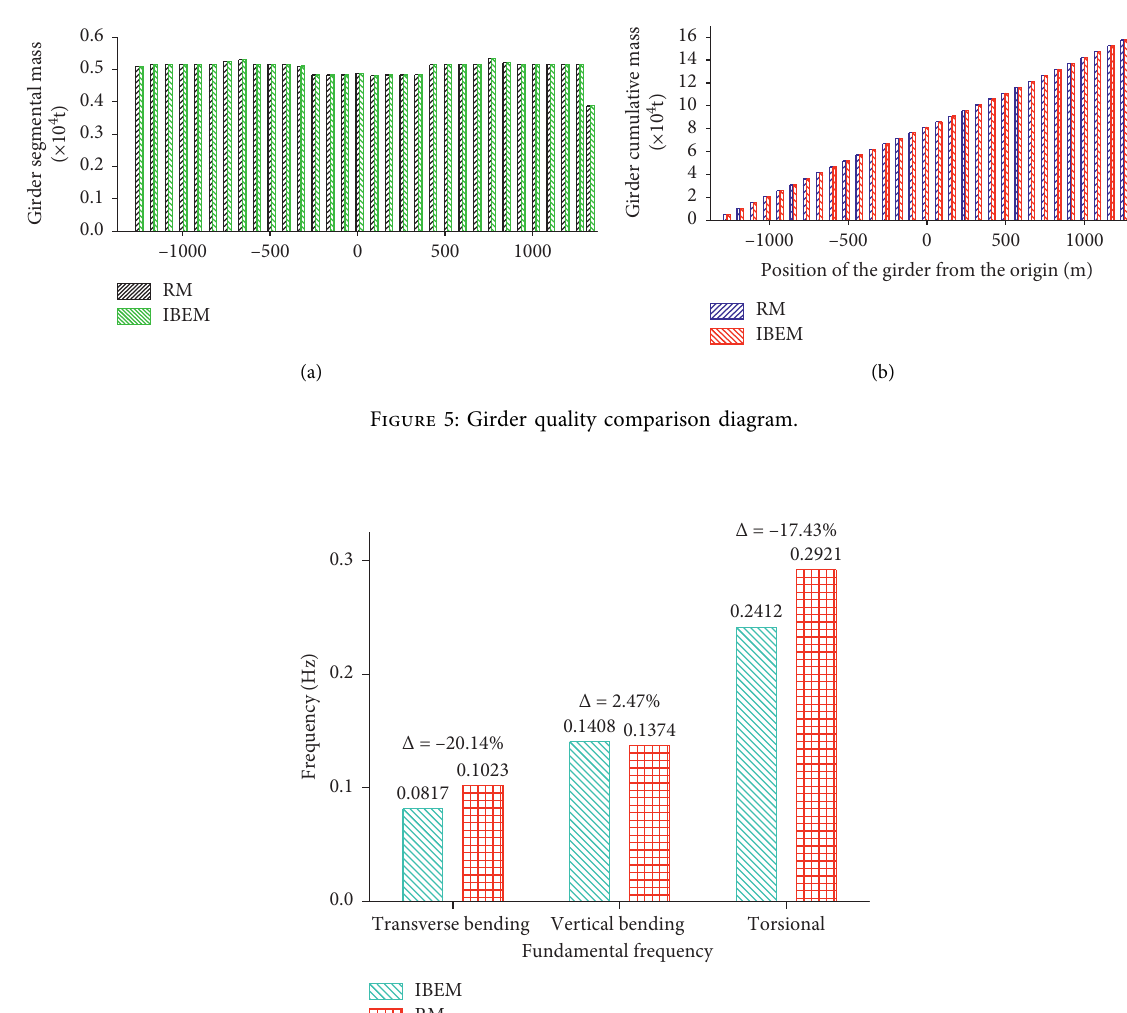
Figure 6: Fundamental frequency difference of the finished state. And Δ � calculation value of IBEM − calculation valueof RM/calculationvalueof RM ×